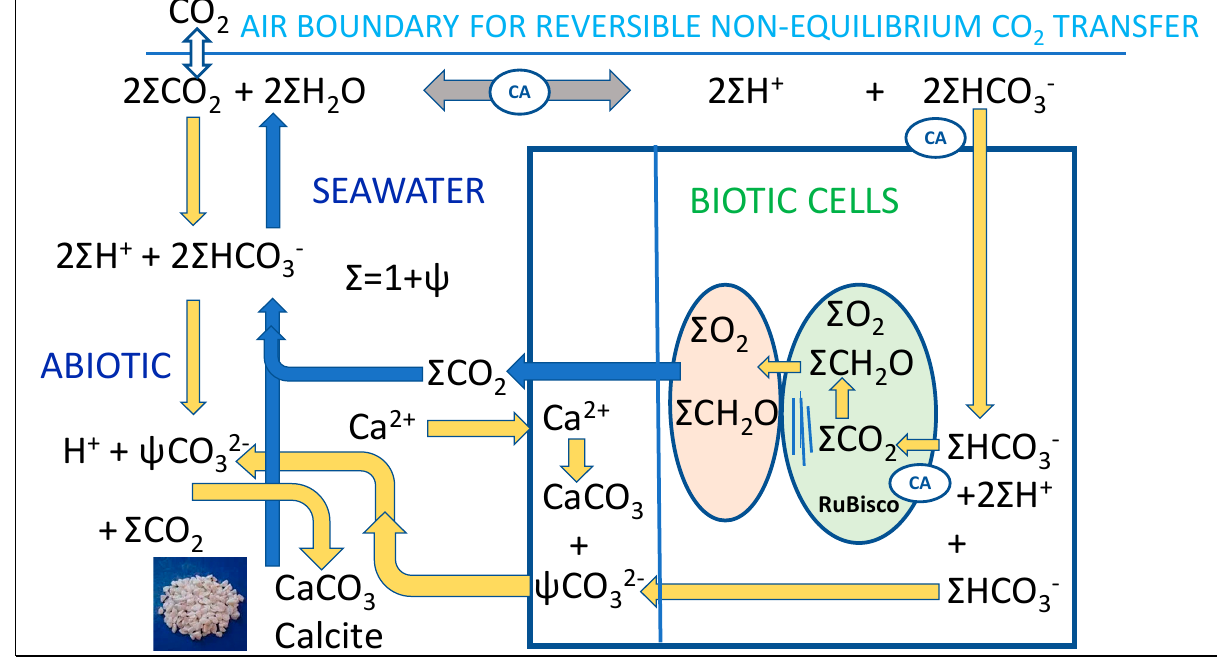
Figure 9. Abiotic and biotic processes for calcite formation and dissolution in surface seawater. Predominant seasonal processes are shown as summer (yellow) and winter (blue), including composite reactions according to Equation (20) involving emission and absorption of CO 2 . Activity by phytoplankton at the boundary layer with air, possibly using carbonic anhydrase (CA) to generate CO 2 or bicarbonate. Abiotic and biotic processes can achieve calcification independently, though responsive to many factors in common.